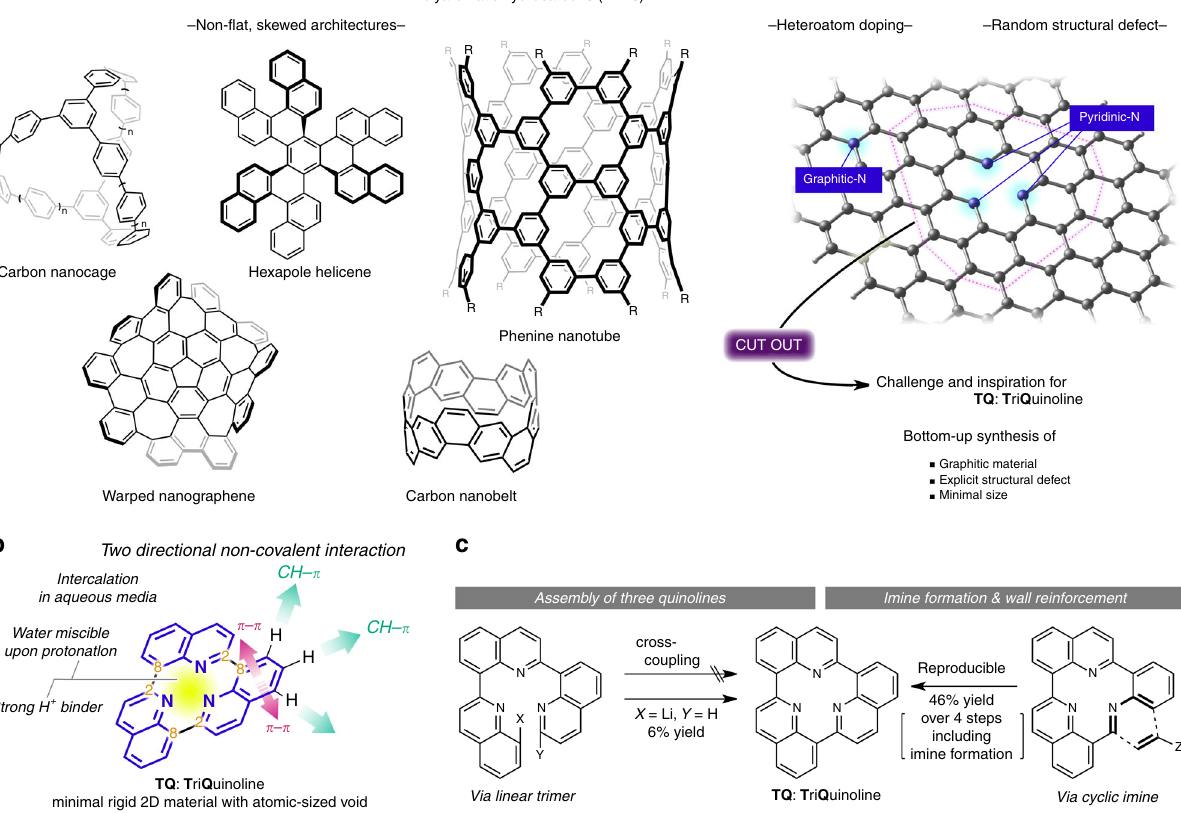
Fig. 1 Overview and inspiration for this work. a State-of-the-art on polyaromatic hydrocarbon research. Structures of seminal non- fl at and skewed graphitic materials: carbon nanobelts and hexapole helicene. Arbitrary doping of nitrogen atoms in PAHs furnishes graphitic nitrogen and pyridinic-nitrogen centres, whereby the latter affords a one-atom defect. Bottom-up synthesis of a miniaturised graphitic material with pyridinic nitrogens corresponding to TQ: TriQuinoline. b Overview of the structural and chemical properties of TQ. c Unsuccessful attempts to synthesise TQ and an alternative viable synthetic